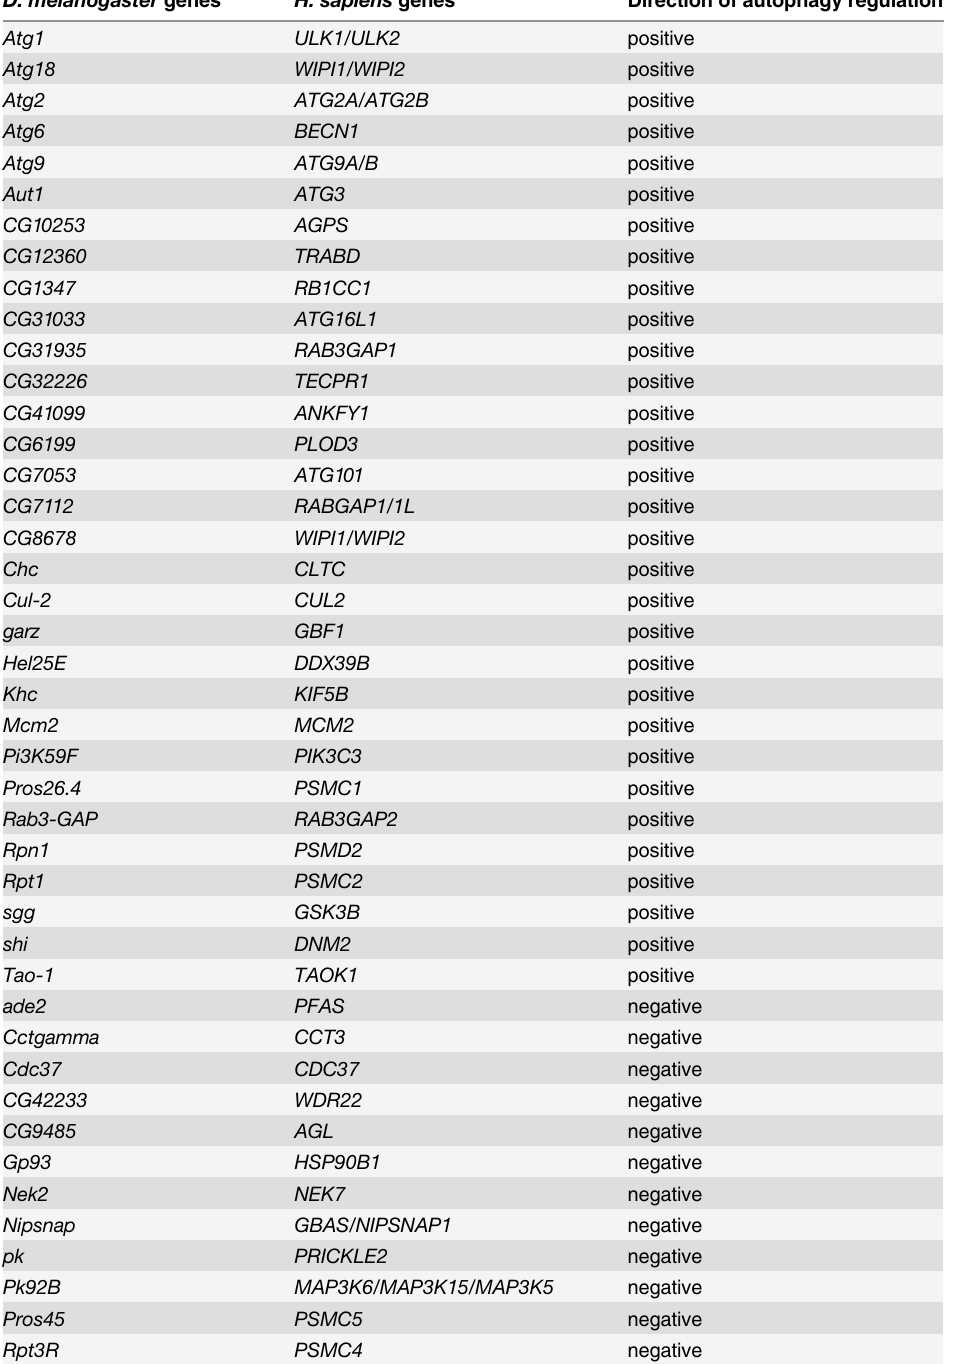
Table 1. List of genes with two or more dsRNAs scoring in primary culture